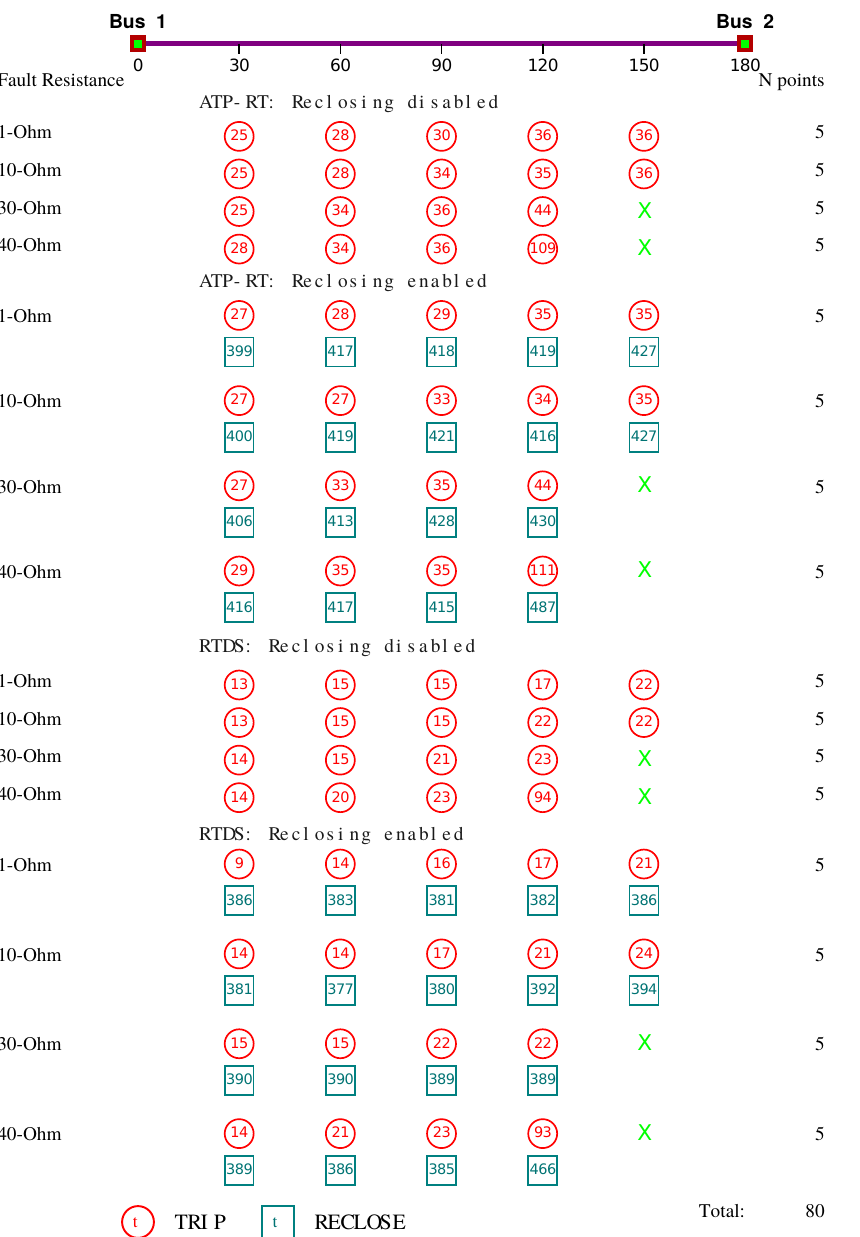
Figure 5. Tests conducted using the Alternative Transients Program-Real Time (ATP-RT) and real-time digital simulator